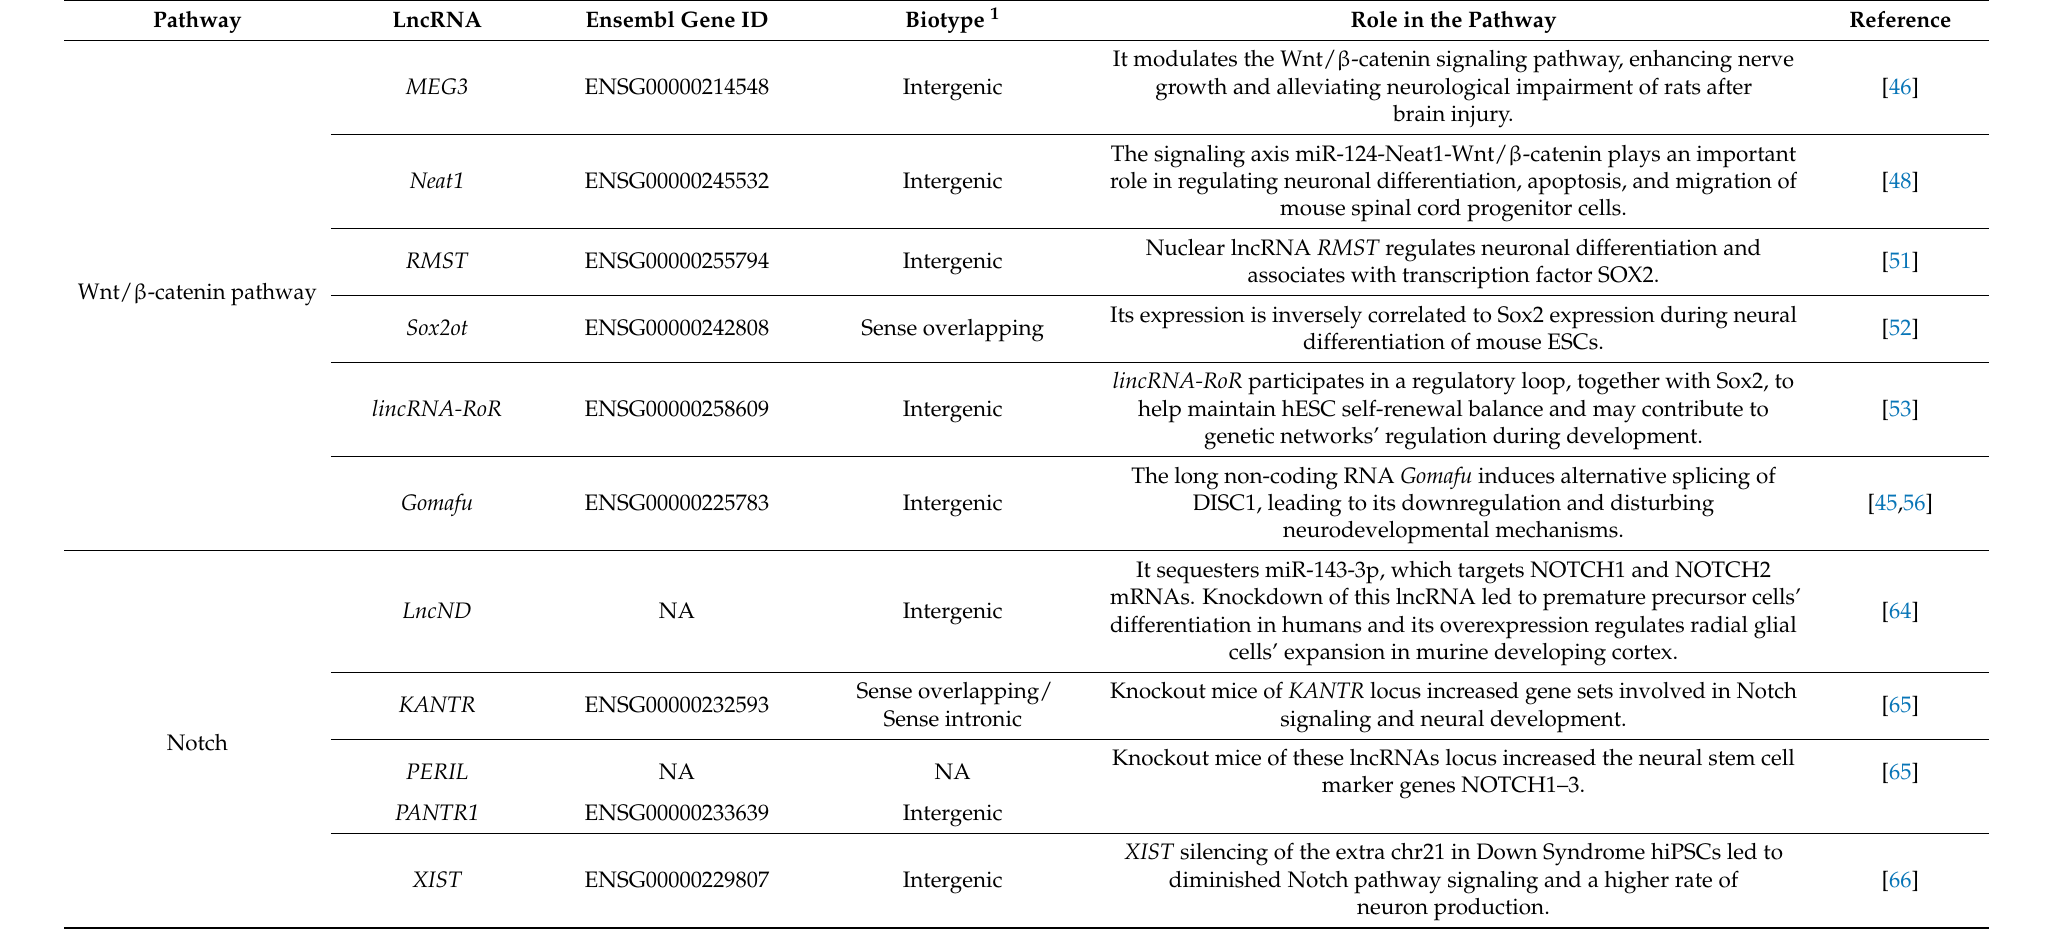
Table 1. Overview of lncRNAs roles in each non-syndromic intellectual disability-related